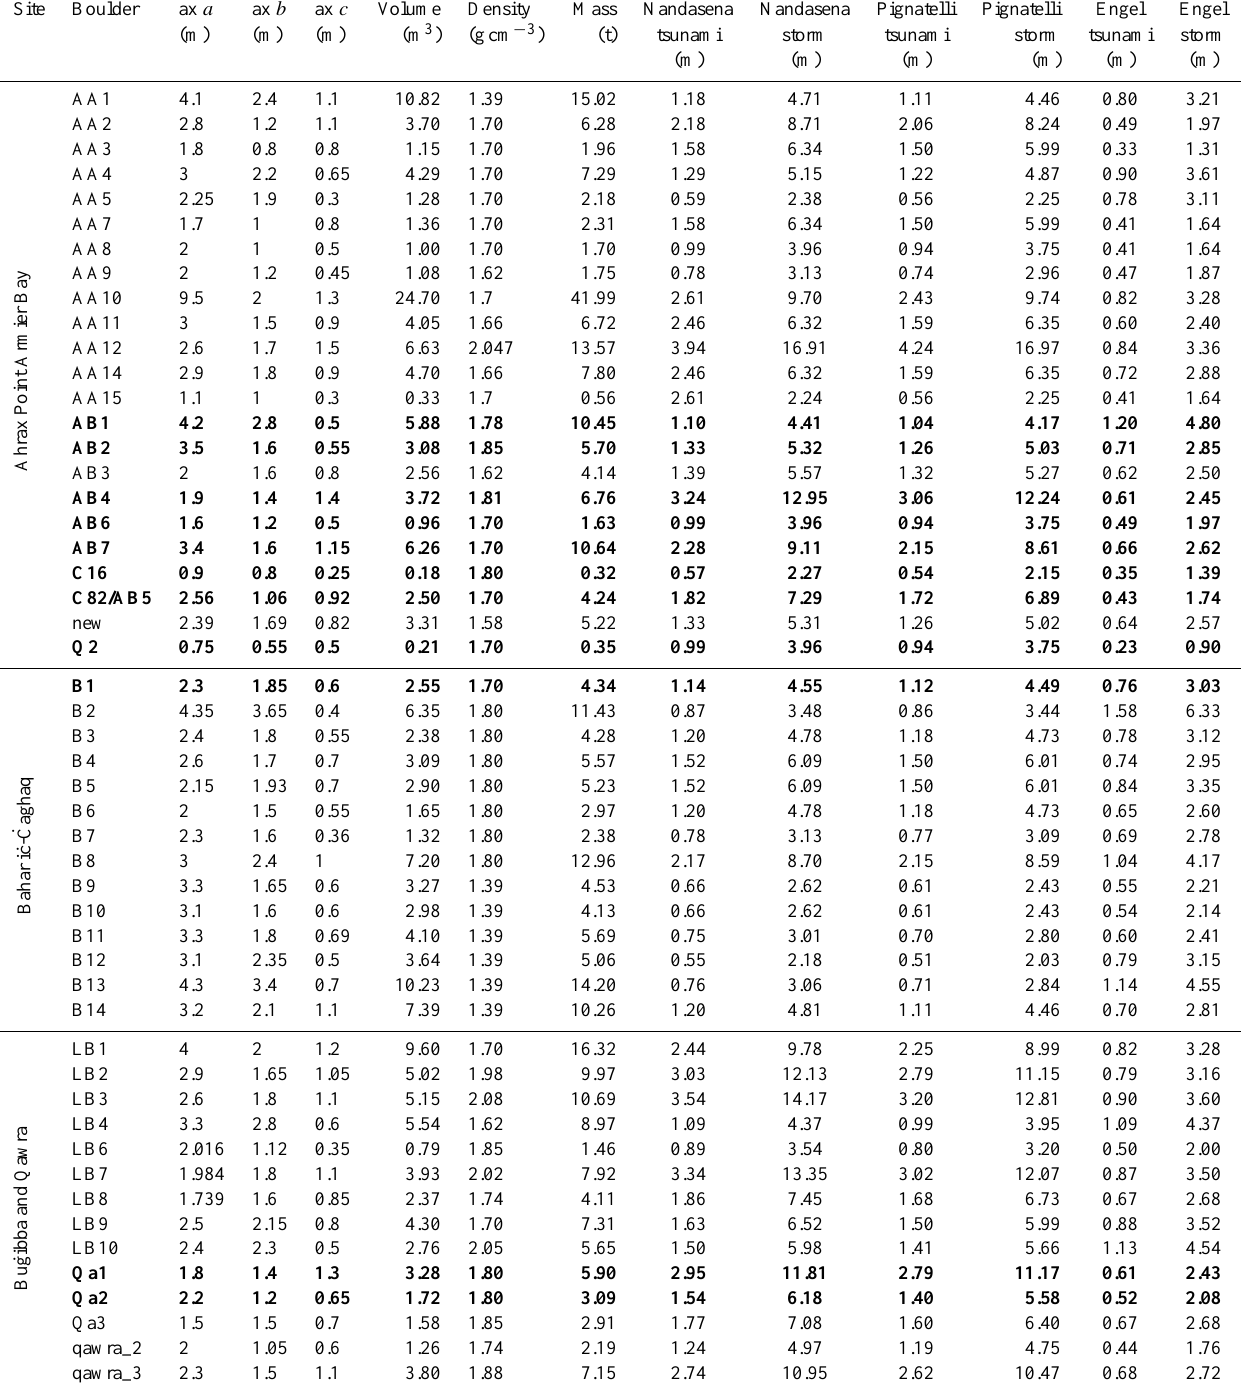
Table 3. Physical parameters of the boulders and results of the application of the hydrodynamic equations provided by Nandasena et al. (2011), Pignatelli et al. (2009) and Engel and May (2012). The dated boulders are reported in bold characters.